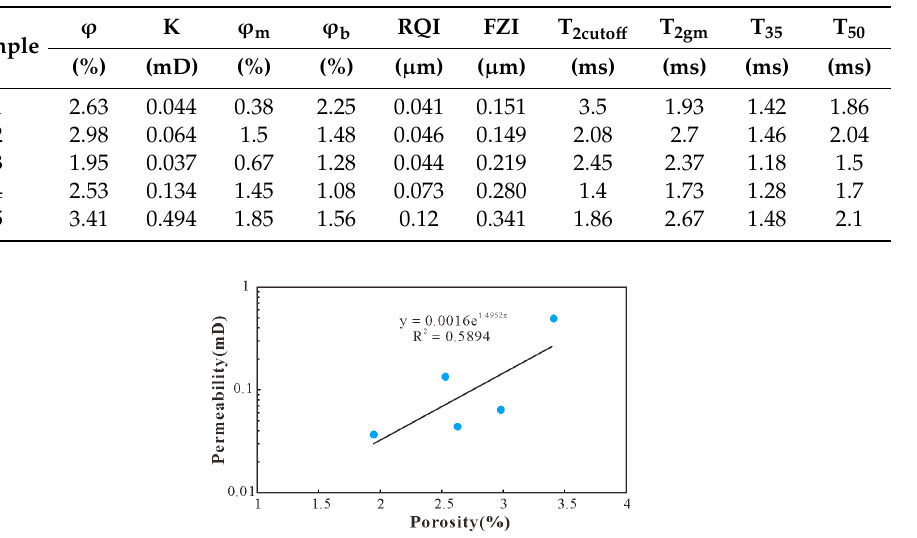
Figure 4. The correlation between porosity and permeability of P 1 t sandstone.